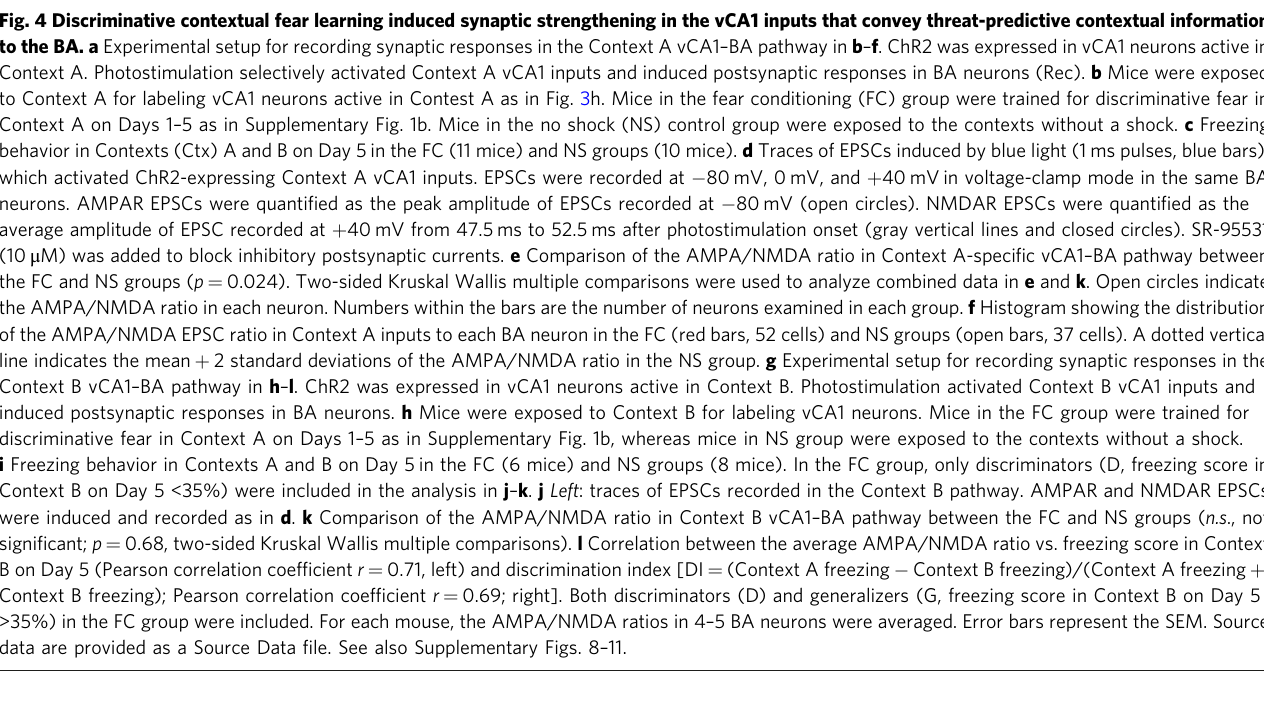
Fig. 4 Discriminative contextual fear learning induced synaptic strengthening in the vCA1 inputs that convey threat-predictive contextual information to the BA. a Experimental setup for recording synaptic responses in the Context A vCA1 – BA pathway in b – f . ChR2 was expressed in vCA1 neurons active in Context A. Photostimulation selectively activated Context A vCA1 inputs and induced postsynaptic responses in BA neurons (Rec). b Mice were exposed to Context A for labeling vCA1 neurons active in Contest A as in Fig. 3h. Mice in the fear conditioning (FC) group were trained for discriminative fear in Context A on Days 1 – 5 as in Supplementary Fig. 1b. Mice in the no shock (NS) control group were exposed to the contexts without a shock. c